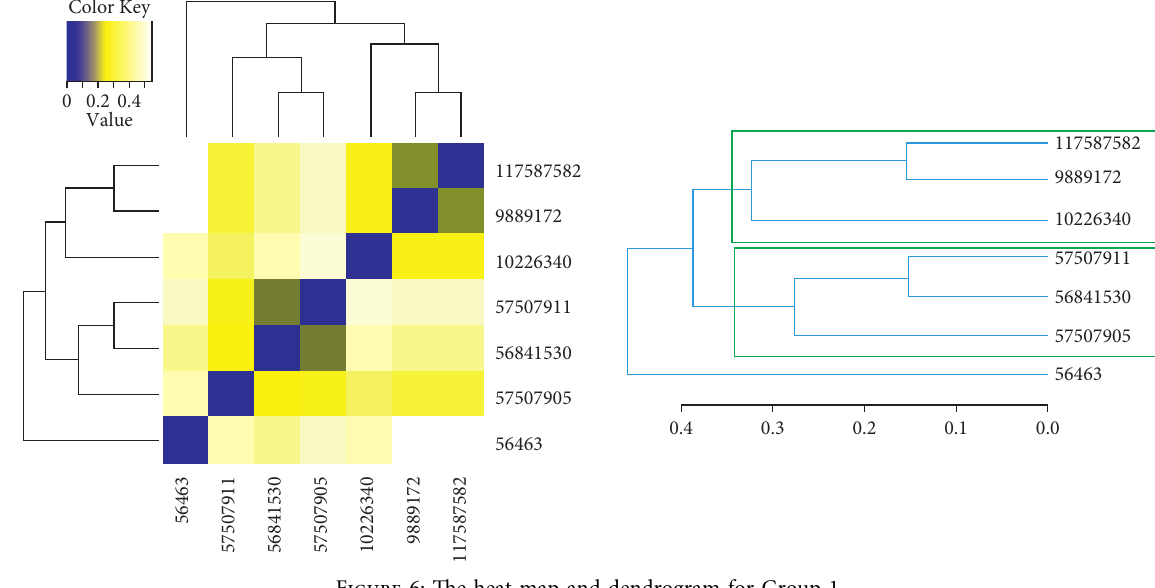
Figure 6: The heat map and dendrogram for Group